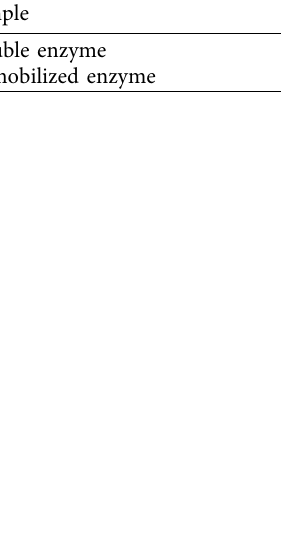
Figure 5: Reuse cycle of the immobilized enzyme. Assume the initial enzyme activity was 100%. The data are presented as mean ± SD; n � 2; a significant difference � p < 0 . 05. The error bars represent standard deviations from two replicates measurements.